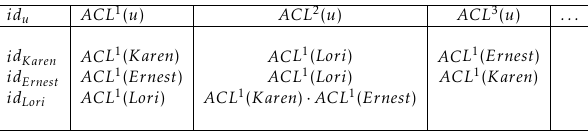
Figure 3. Example of the propagation procedure - phase 2